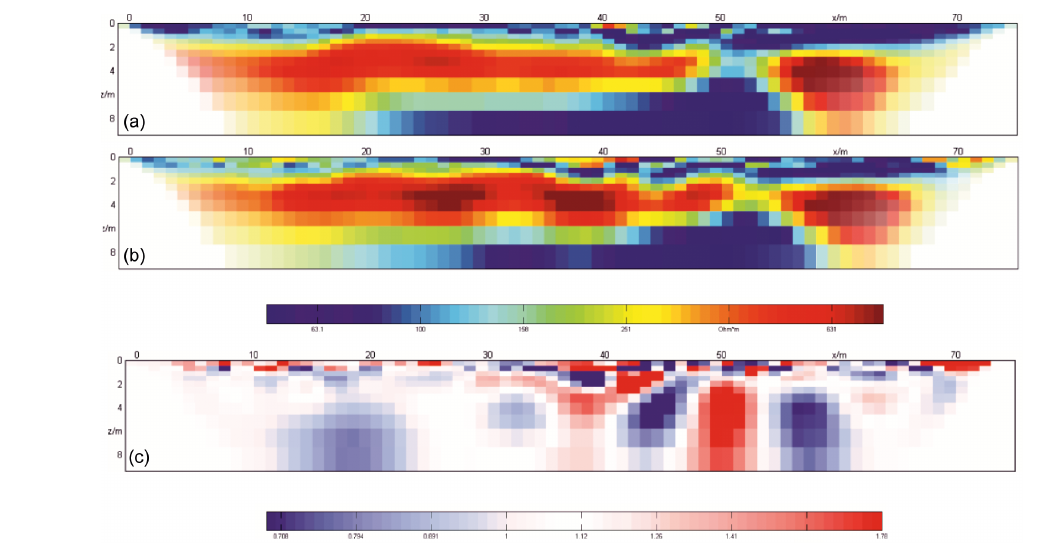
Figure 5. Results of repeated 2-D resistivity surveys at the central mofette in Hartoušov, (a) inversion model of the resistivity ( (cid:127) m) distribu- tion measured in May 2007, (b) inversion model of the resistivity distribution measured in October 2016 (inversion code DC2DInvRes) and (c) relative change in the subsurface resistivity by inversion of the ratio of data from the initial (2006) and later (2016) data sets. A variation of 1 means that the resistivity has not changed, a variation of 1.2 represents an increase of 20%.